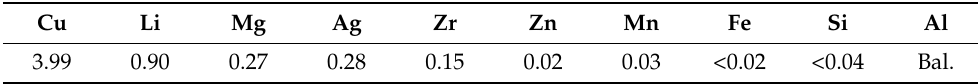
Table 1. Elemental ingredients of the 2195 ingot (wt.